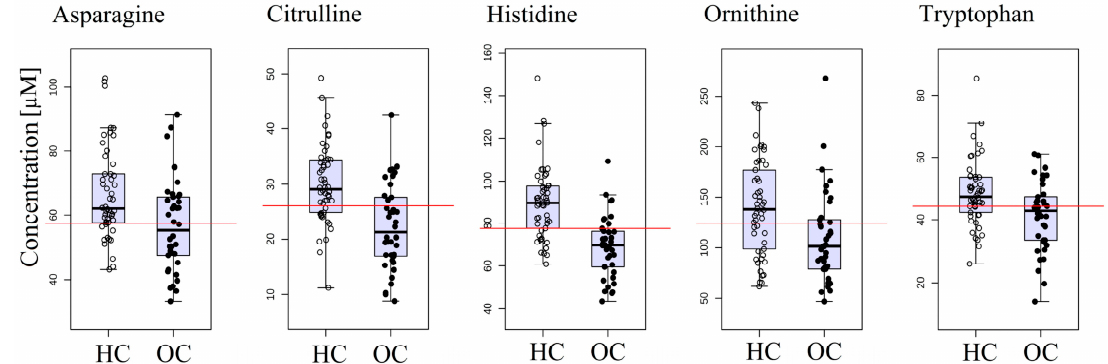
Figure 1. Serum concentrations of 5 amino acids that obtained the lowest p -value in the comparison between ovarian cancer (OC) patients and healthy control (HC) group. The optimal cutoff values based on univariate ROC curve analysis are overlaid on the box-plots.